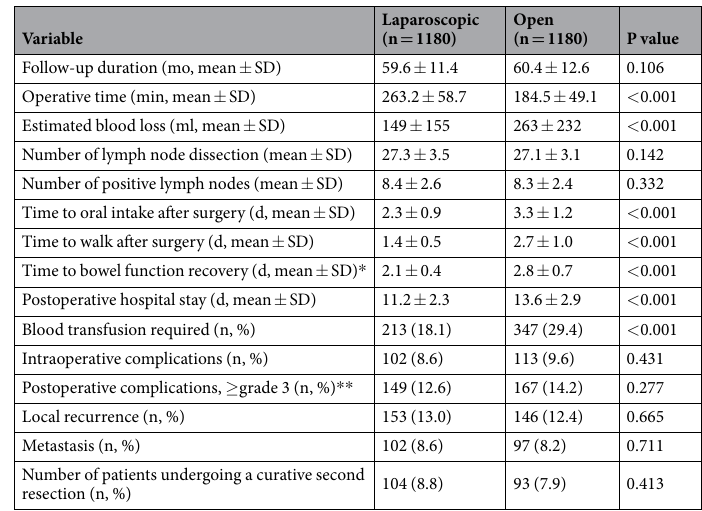
Table 2. Intraoperative and postoperative results. SD, standard deviation. * Defined as time of anal exhaust or defecation. ** According to the Clavien-Dindo